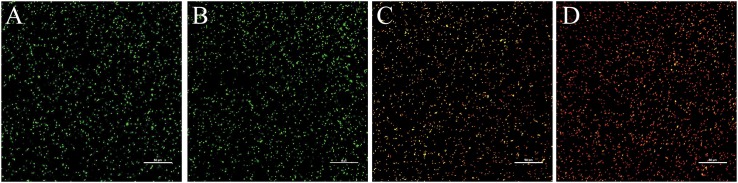
Confocal laser scanning microscope images of L. monocytogenes. Untreated bacterial cells incubated for 90 min (A) or 150 min (B), and bacterial cells treated with LED illumination for 90 min (C) or 150 min (D) were visualized under the confocal laser scanning microscope.